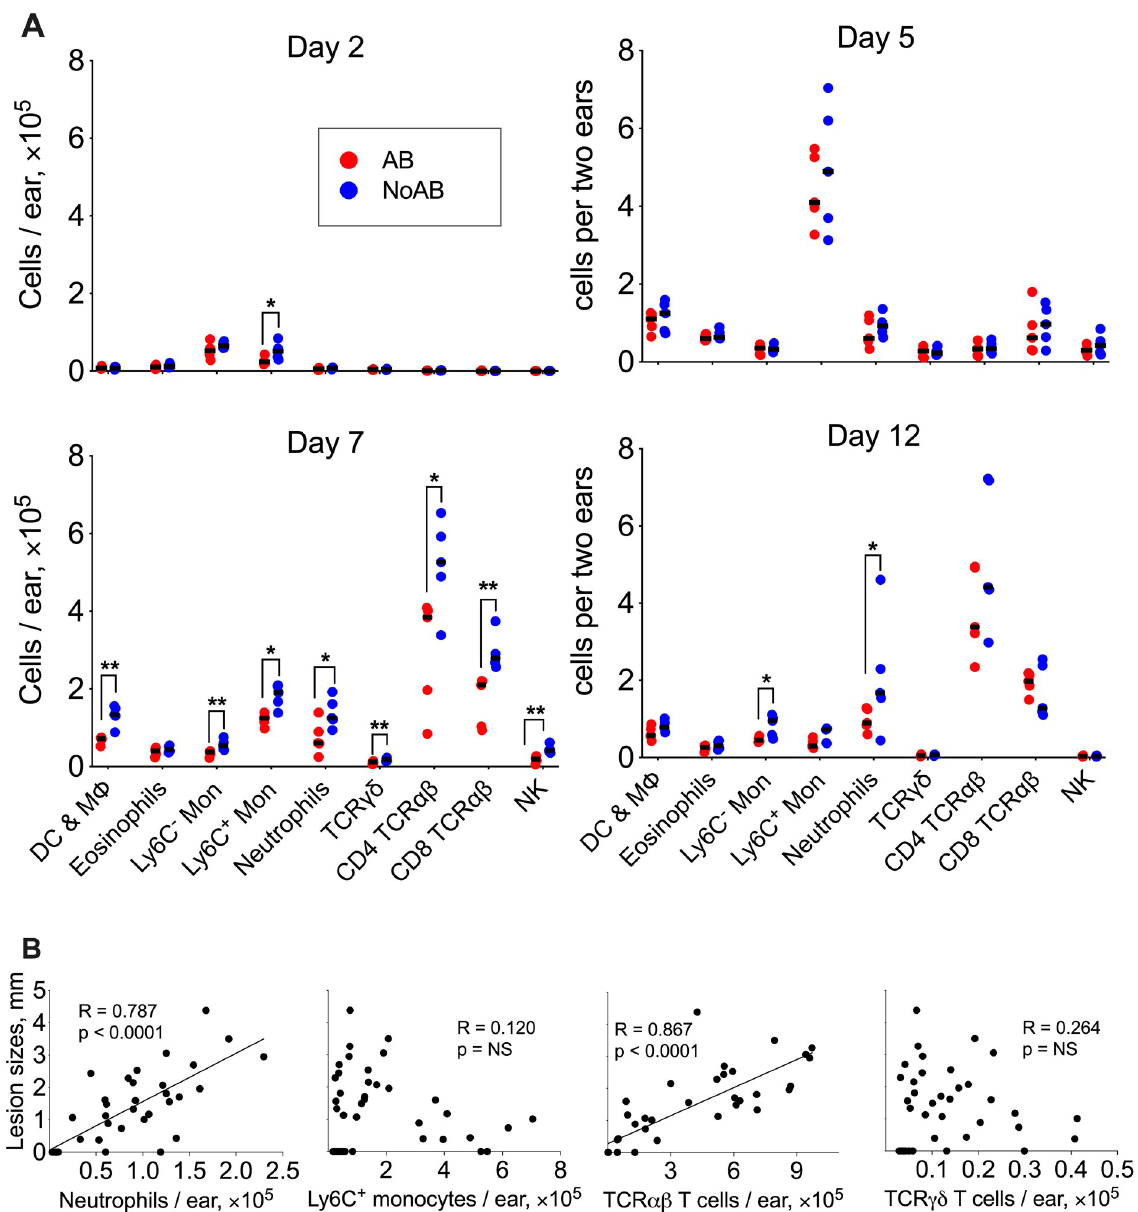
Fig 5. Skin microbiota advance immune cell recruitment into VACV infected tissue. Two groups of SPF mice were infected i.d. with 10 4 PFU of VACV. From d 1 p.i. onwards, one group (AB) received antibiotic (ceftriaxone) i.p. daily. The second group (NoAB) received PBS i.p. (A) Numbers of myeloid and lymphoid cell of subpopulations were measured in ear tissues at 2, 5, 7 and 12 d p.i. (n = 5 per group per time point). DC & M F , dendritic cells and macrophages; Mon, monocytes, TCR γδ , TCR γδ + T cells; TCR αβ CD4, TCR γδ - CD4 + T cells; TCR αβ CD8, TCR γδ - CD8 + T cells. Medians are shown; p values were determined by the Mann-Whitney test, � = p < 0.05, �� = p < 0.01. (B) Spearman correlation analysis of lesion sizes versus numbers of neutrophils, Ly6C+monocytes, TCR γδ T cells or TCR αβ (TCR γδ - ) T cells recruited to site of infection. The experiment was performed twice and representative data from one experiment are